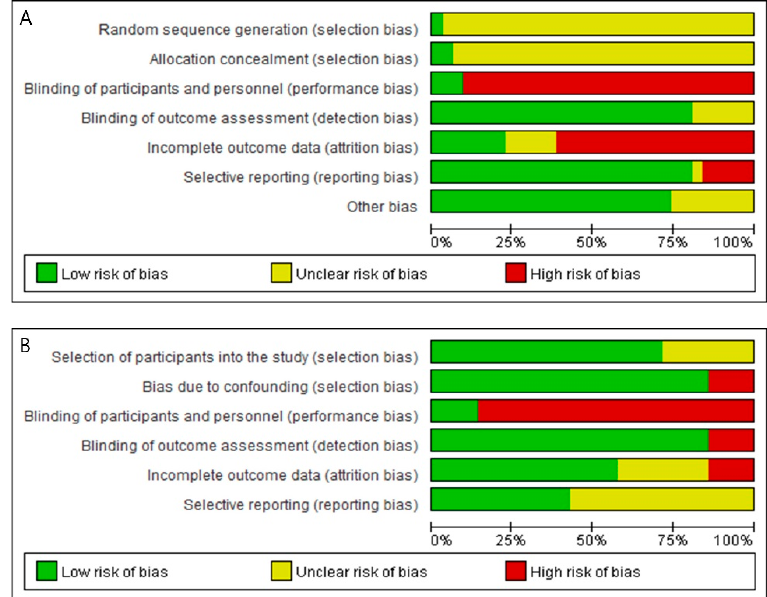
Figure3. Riskofbiasgraph: ( A )Riskofbiasgraphofrandomizedcontrolledtrials(RCTs); ( B )Riskofbias Figure 3. Risk of bias graph: ( A ) Risk of bias graph of randomized controlled trials (RCTs); ( B ) Risk graphofcontrolledclinicaltrials(CCTs).3.3.2. RiskofBiasinClinicalControlledTrials(NonRandomized of bias graph of controlled clinical trials (CCTs).3.3.2. Risk of Bias in Clinical Controlled Trials (Non Studies) ( n = Randomized Studies) ( n = 7).